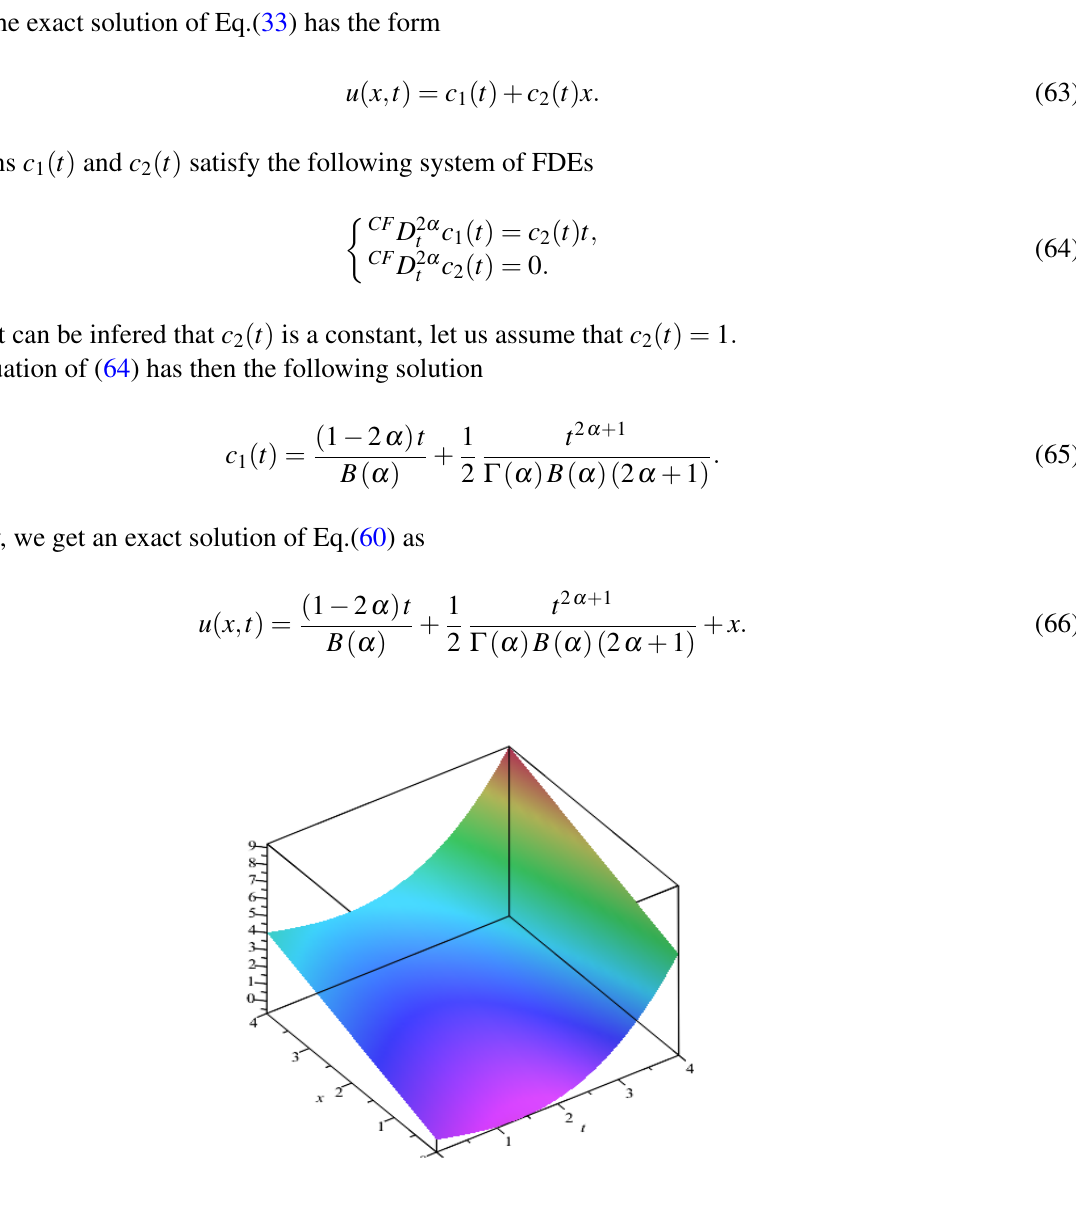
Fig. 8 Profile of the solution (66) for α = 0 . 9